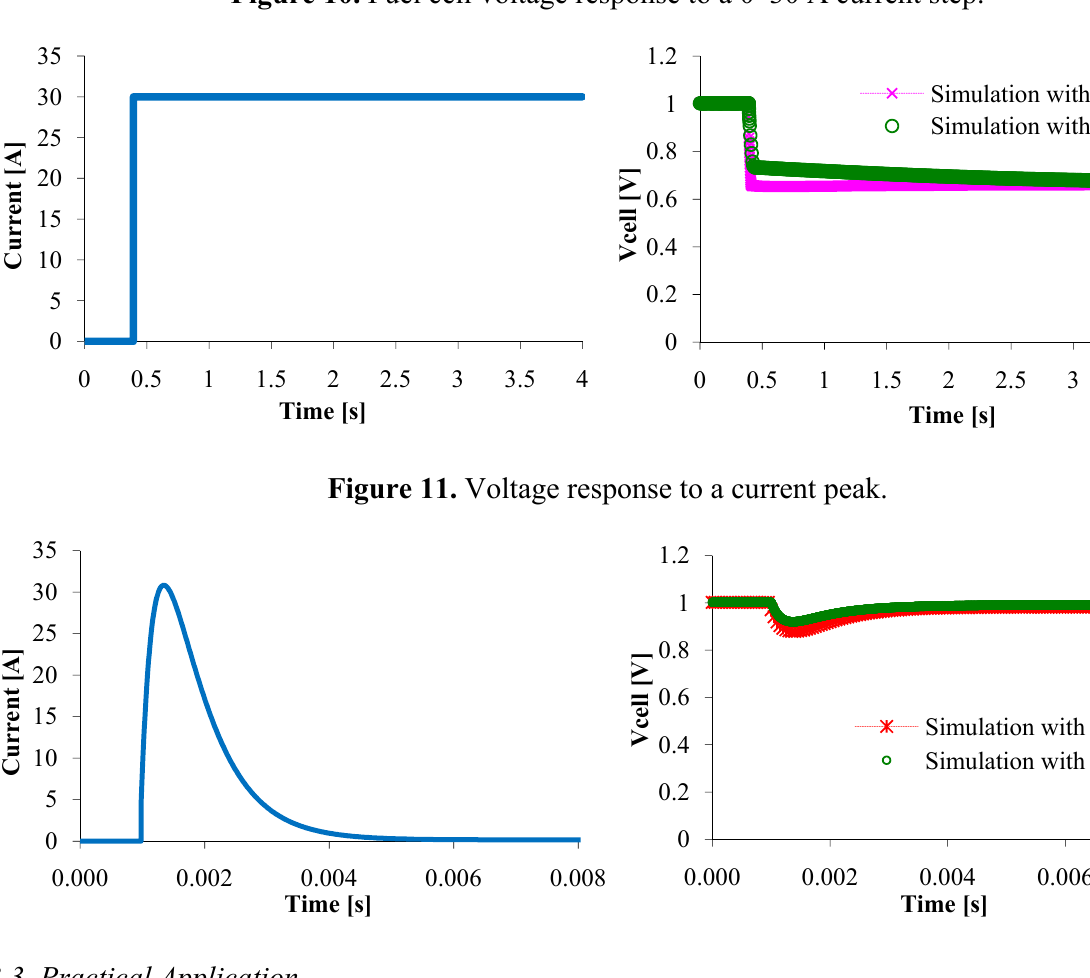
Figure 10. Fuel cell voltage response to a 0–30 A current step.